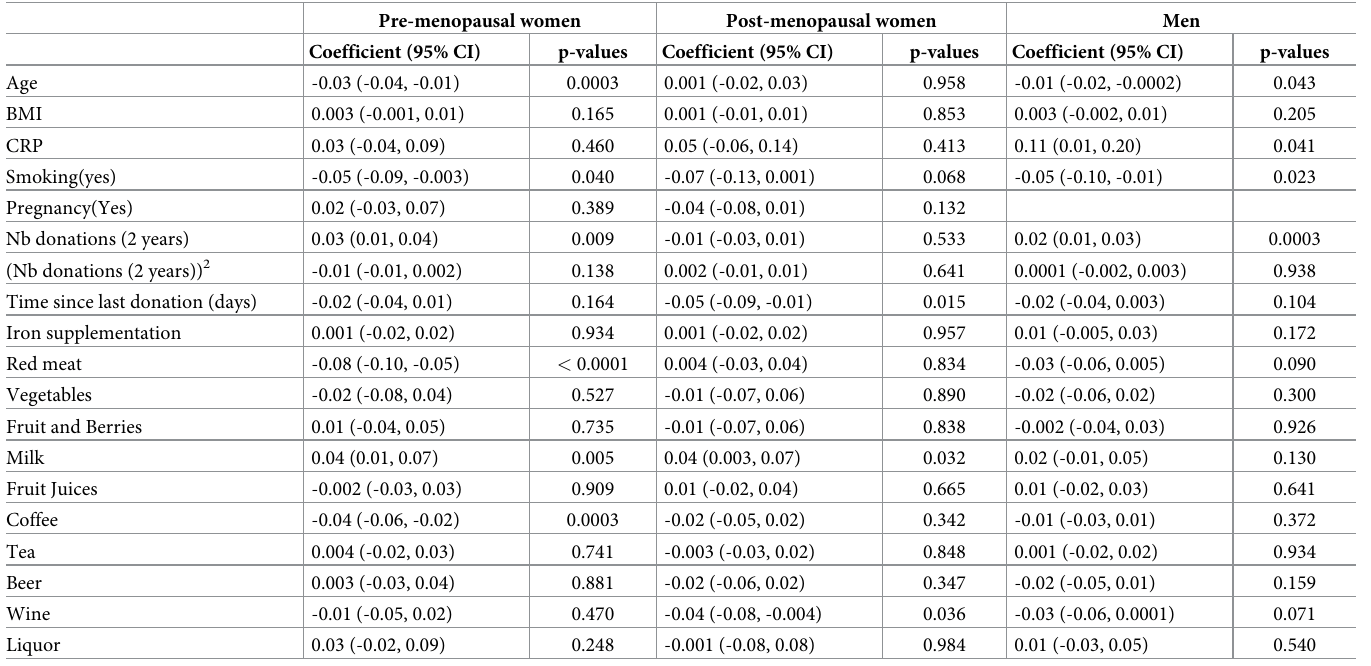
Table 4. Multiple robust regression results for sTfR